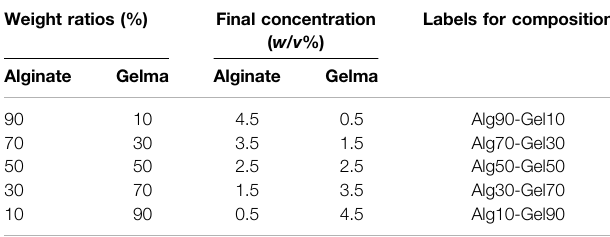
TABLE 1 | Labels for functional composition of different ratios and concentration. Weight ratios